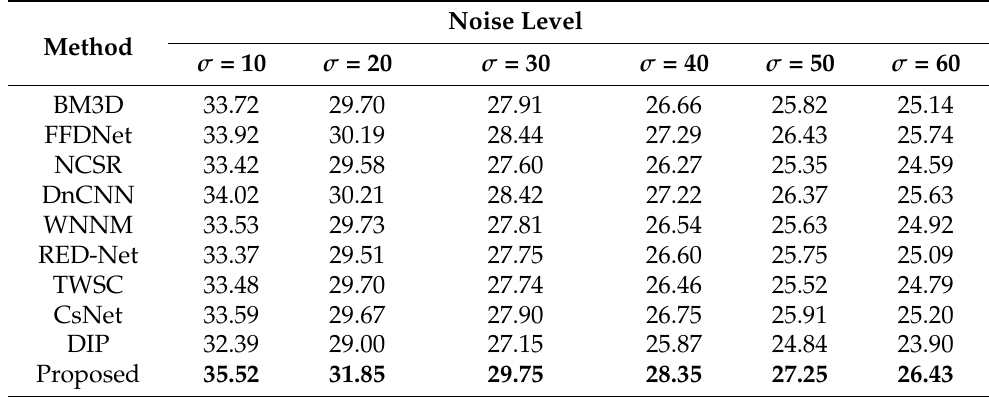
Table 9. Average PSNR results of different methods on BSD50 with various noise levels.